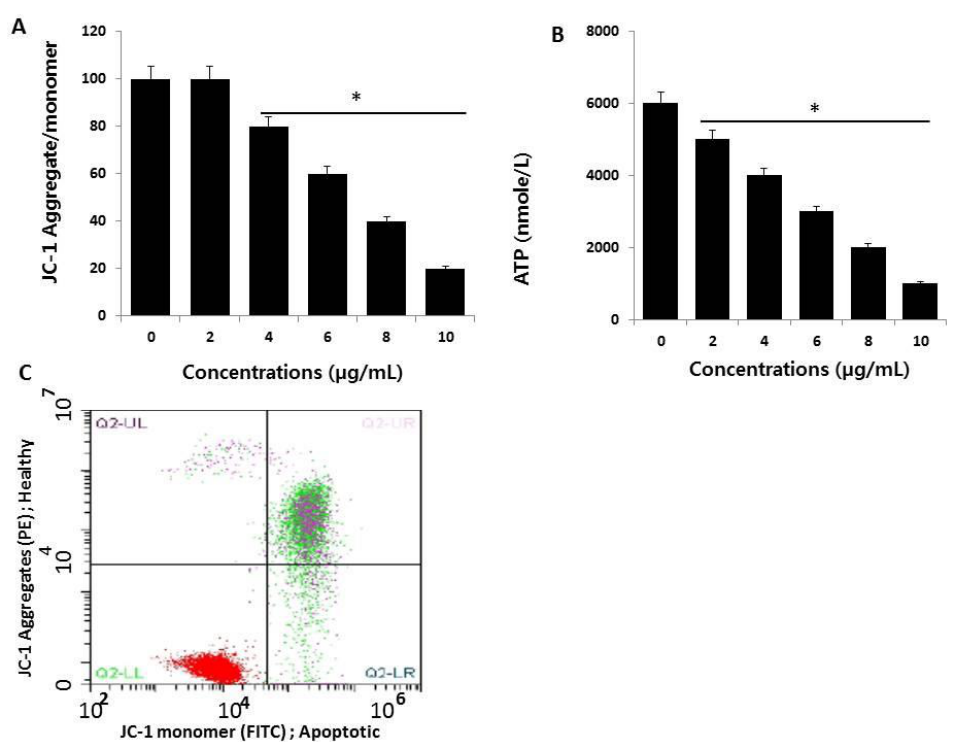
Figure 5. Measurement of mitochondrial membrane potential (MMP) and ATP. ( A ) HCT116 cells